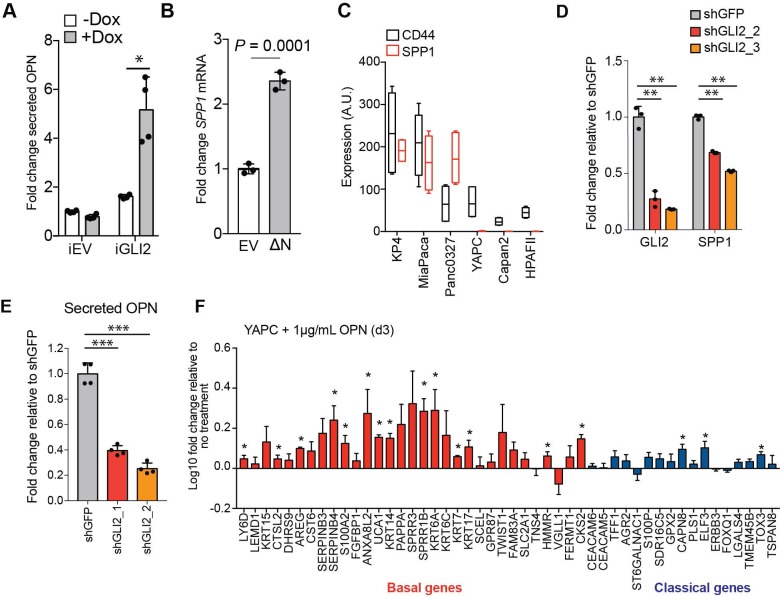
OPN is a downstream effector of GLI2 and promotes the basal-like subtype of PDA.(A) Graph shows the relative fold change in human OPN in the conditioned media of YAPC-iEV and -iGLI2 cells treated with 1 μg/mL Dox for 3 days as measured by ELISA. All values are normalized to OPN levels in YAPC-iEV grown in the absence of Dox. (B) Graph shows relative fold change in SPP1 mRNA levels following transient expression of ΔN-GLI2 (ΔN) in YAPC cells. (C) Graph represents mRNA levels of SPP1 and CD44 in the indicated human PDA cell lines as measured by qRT-PCR. (D,E) Effect of shRNA-mediated knockdown of GLI2 with two distinct hairpins on the mRNA expression of the indicated genes (D) and secreted OPN as measured by ELISA (E) in Panc0327 cells. (F) Expression of basal-like and classical subtype genes as measured by qRT-PCR following treatment of YAPC cells with 1 μg/mL recombinant human OPN for 3 days. Values are normalized to no treatment and log10 transformed. Error bars are plotted as s.e.m. p-Values were calculated by two-tailed unpaired t test. *p<0.05; **p<0.01; ***p<0.001.